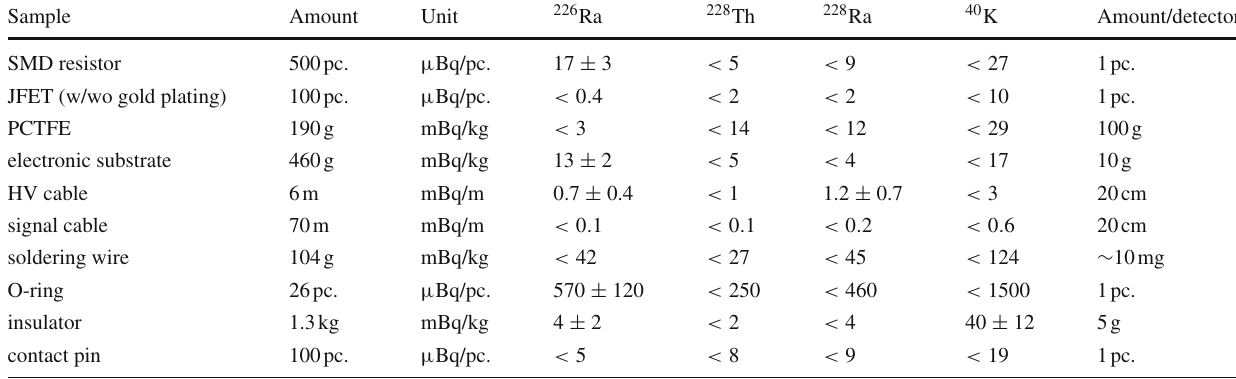
Table 3 Radio-impurity concentrations of the main material components used for the Conus detector construction. Further, the typical quantities of materials deployed inside the end cap of a single detector unit are presented in the last column